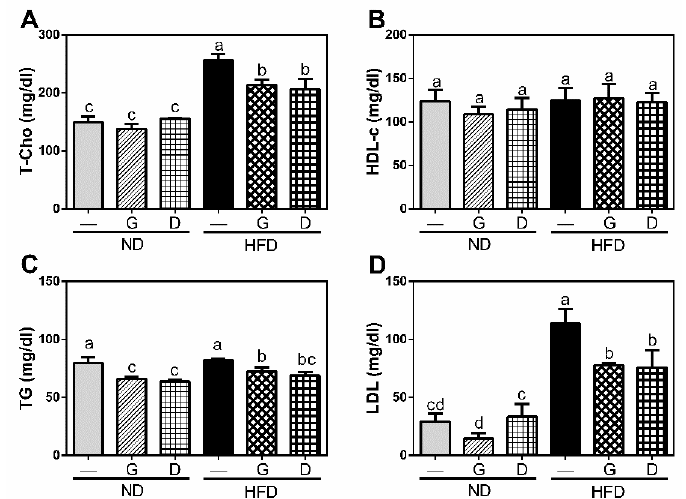
Figure 3. Influence of garlic supplementation on serum level of lipid profiles including total cholesterol (T-Cho) ( A ), high density lipoprotein cholesterol (HDL-c) ( B ), total triacylglycerol (TG) ( C ), and low-density lipoproteins (LDLs) ( D ). The data represent the mean ± SD of five mice for each group. Columns with different letters significantly differ ( p < 0.05).